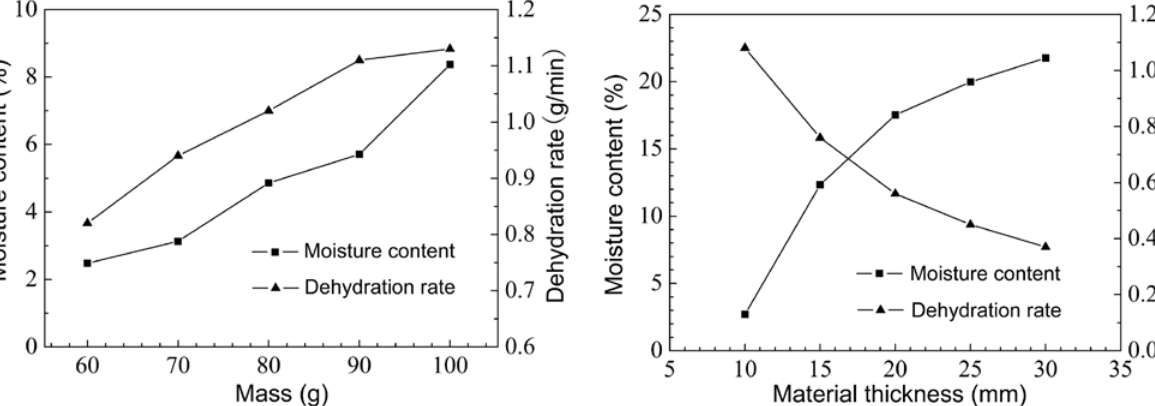
Figure 5: The effect of material mass on moisture content and dehy- dration rate of zinc oxide leach residues.